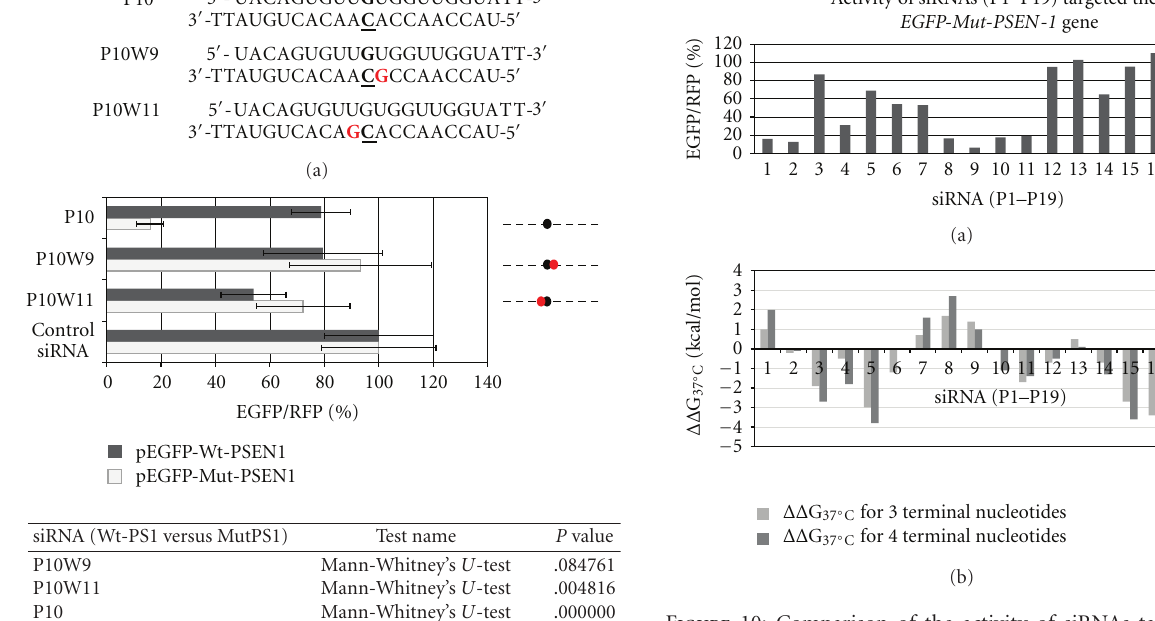
Figure 10: Comparison of the activity of siRNAs targeted Mut- PSEN1 gene (a) with their thermodynamic data (b). siRNAs were fully complementary to the Mut-PSEN1 transcript. Di ff erences between the free Gibbs energy of 5 (cid:3) -end and 3 (cid:3) -end of the duplex (resp. to the polarity of the antisense strand) were calculated for three and for four consecutive base pairs: ( ΔΔ G 37 ◦ C = Δ G (cid:3) -end) − Δ G (cid:3) -end)) (compare with Table 37 ◦ C (5 37 ◦ C (3